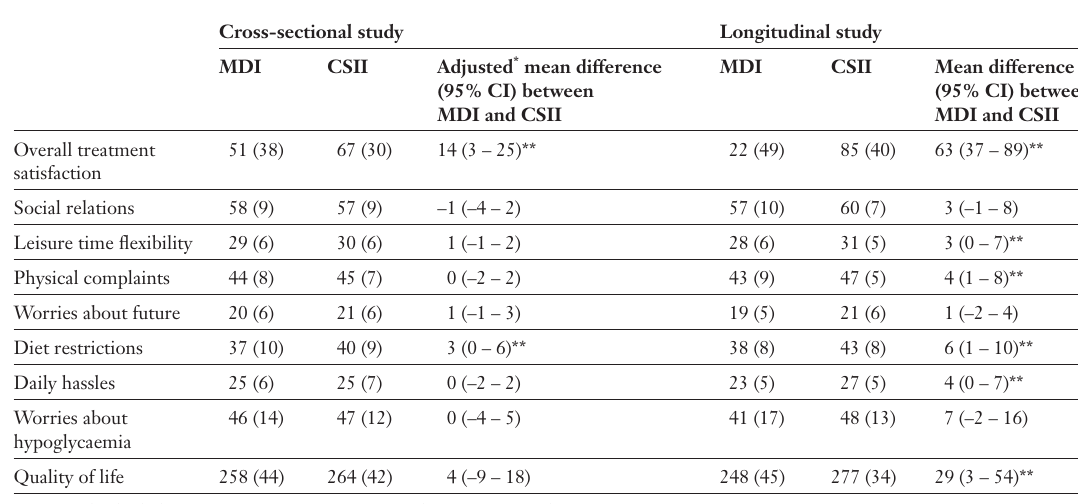
Overall treatment sat- isfaction, daily re- strictions and bur- dens, overall quality of life: mean (stan- dard